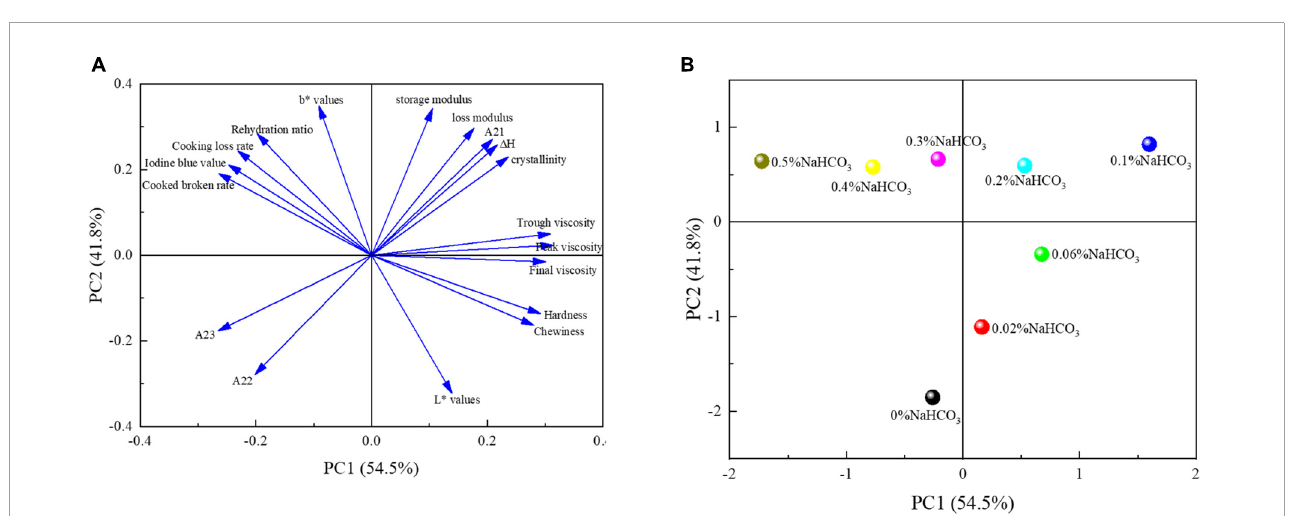
FIGURE7 Principal component analysis of semi-dried rice noodles with different sodium bicarbonate additions. Loading plot of the variables of samples (A) . Score plot of the different samples (B)